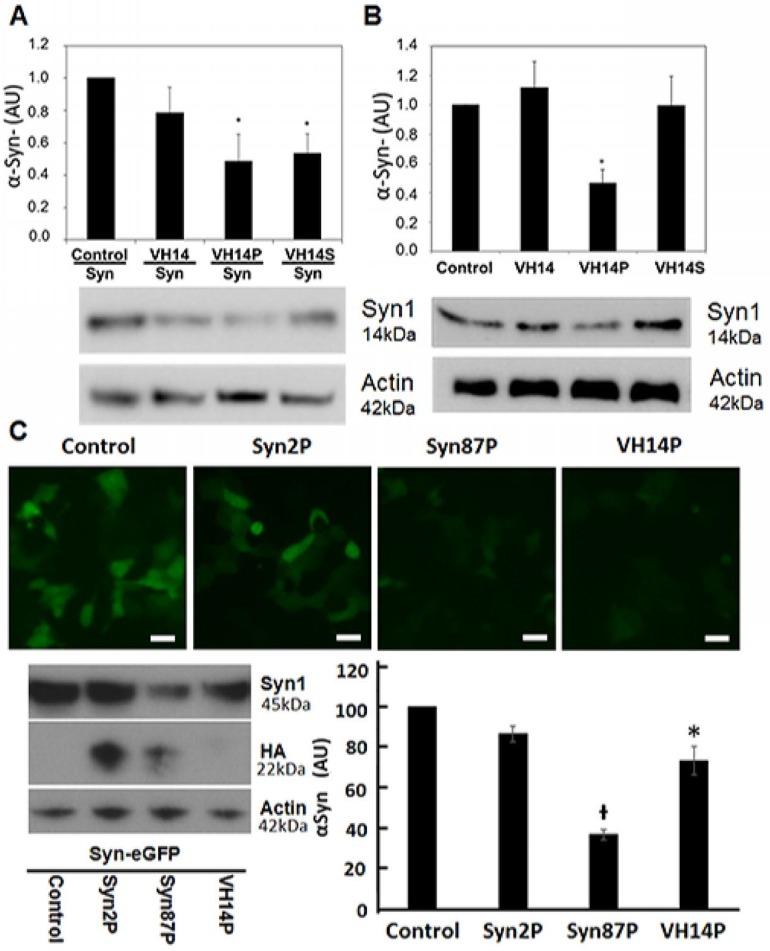
Bifunctional nanobody-PEST reductions of α-Syn levels.(A) Dual transfection of wild type α-Syn plus VH14 constructs in ST14A cells. VH14PEST (VH14P) and VH14 with a scrambled PEST degron (VH14S) significantly reduced (*p<0.05, n = 5) α-Syn based on Western blot densitometry of α-Syn compared with VH14 and empty vector control. (B) Endogenous α-Syn after transfection of VH14PEST constructs in SH-SY5Y cells. Western blot densitometry shows that α-Syn is significantly (*p<0.05, n = 4) reduced by VH14P compared with empty vector control, VH14 and VH14S control (C) Live cell imaging, Western blot, and densitometry for Syn with anti-Syn1. Syn87PEST (Syn87P) significantly reduced empty vector control Syn~GFP protein levels compared to VH14P and Syn2P (Mean ± SEM. *p<0.05 compared to Control and Syn87PEST; ᵻ p<0.05 compared to all groups; n = 3).